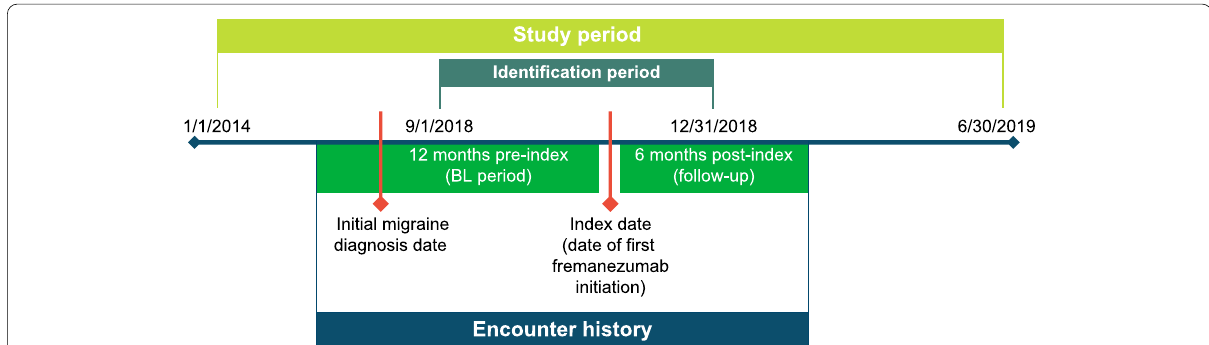
Fig. 1 Overview of study design. BL baseline. Note . The first migraine diagnosis date during the 12-month baseline period was considered the initial diagnosis